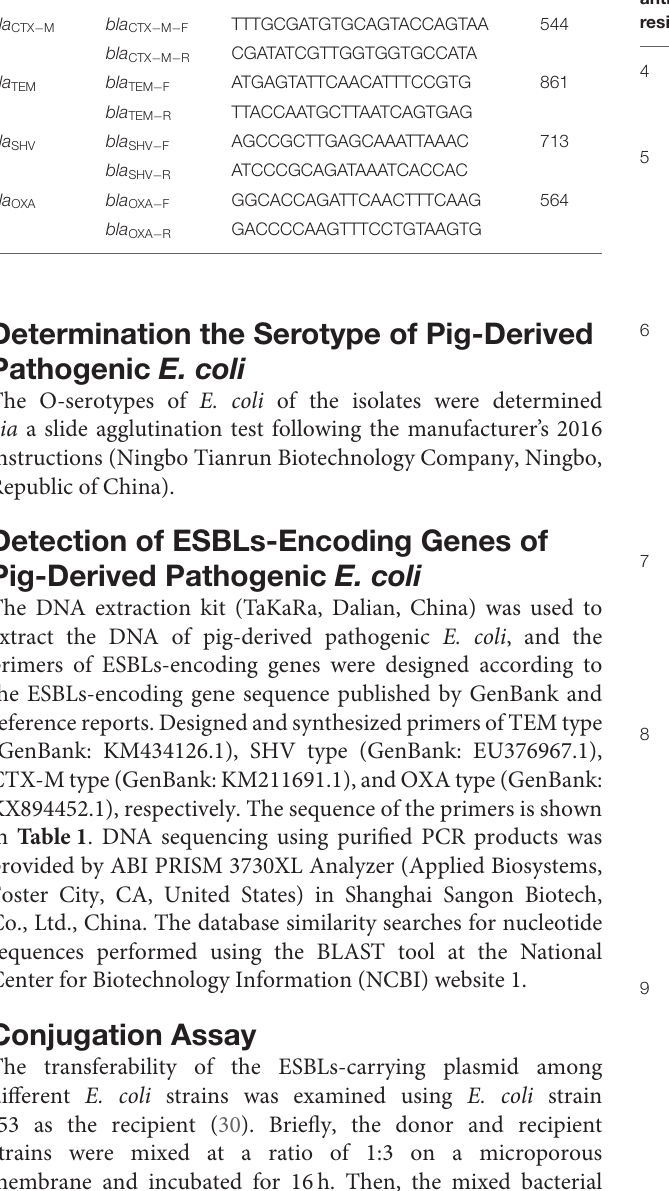
TABLE 1 | Sequences of primers used for PCR. Target gene Primer name Primer sequence (5 ′ -3 ′ )